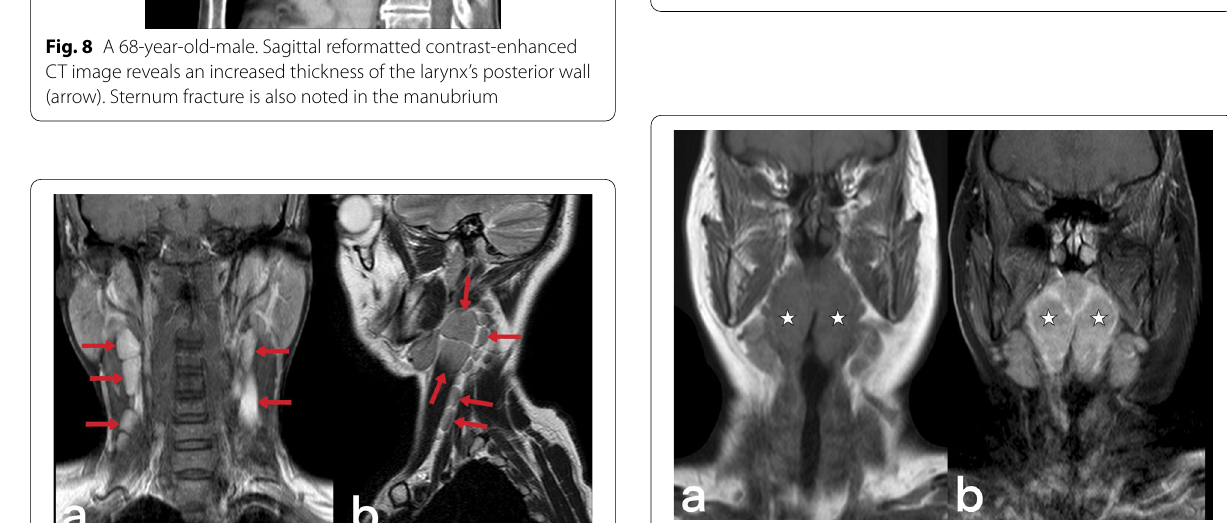
Fig. 11 A 32-year-old male. Painless, discrete, freely mobile, fistulized lumps in the neck are grown progressively ( a ). Ultrasound showed multiple necrotic lymph nodes ( b ). Scrofula of the neck